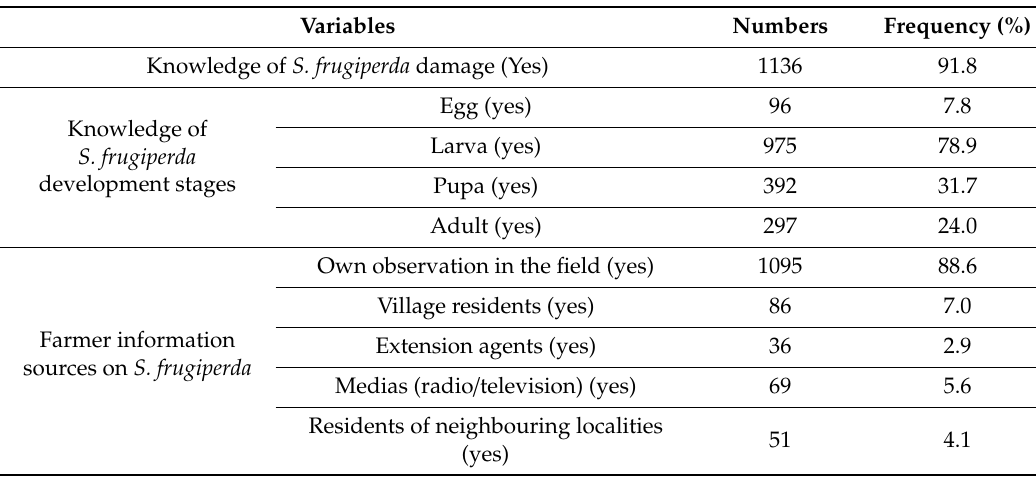
Table 3. Farmers’ knowledge and perceptions of S.